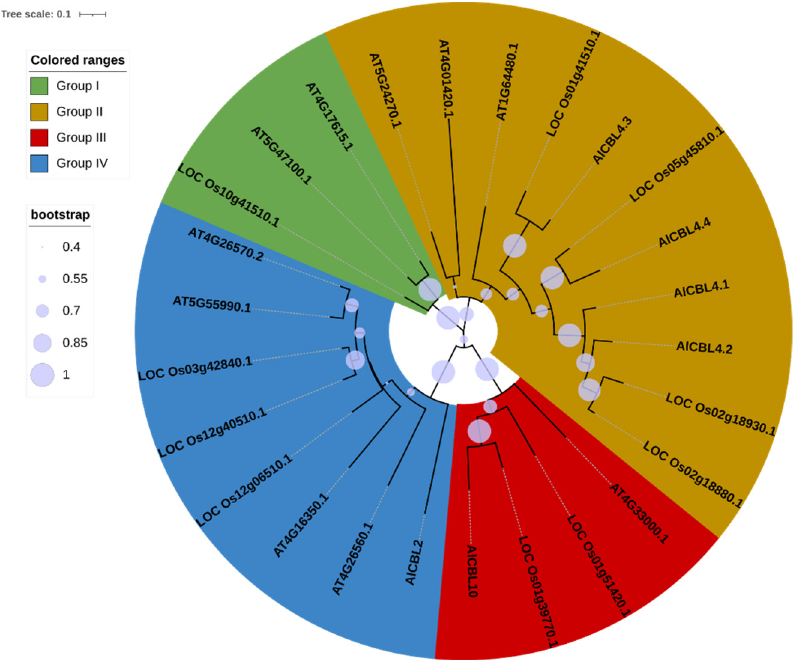
Figure 1. Phylogeny tree of CBL family proteins in A. littoralis (AlCBL), Oryza sativa (started with LOC Os), and A. thalianas (started with AT). The phylogenetic tree was drawn using the maximum likelihood (ML) method with 1000 bootstrap replications.